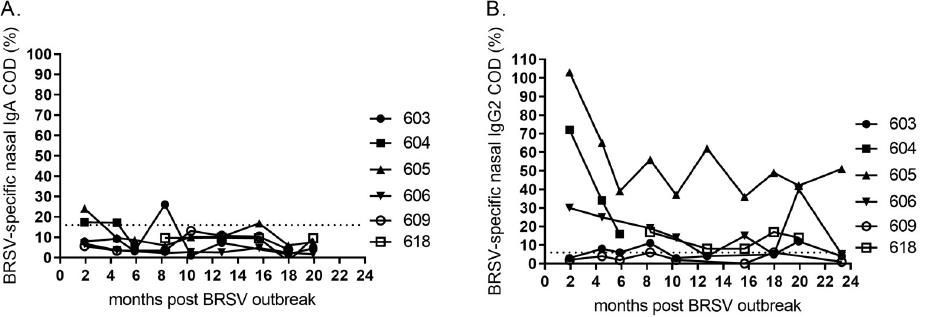
Fig 8. Kinetics of BRSV-specific antibodies in nasal secretions of calves following a BRSV outbreak. (A) Nasal BRSV-specific IgA and (B) nasal BRSV-specific IgG2 following BRSV-infection at 4–5 months of age in January 2016 (month 0). Corrected optical density (COD) values are presented as percentage of a positive control